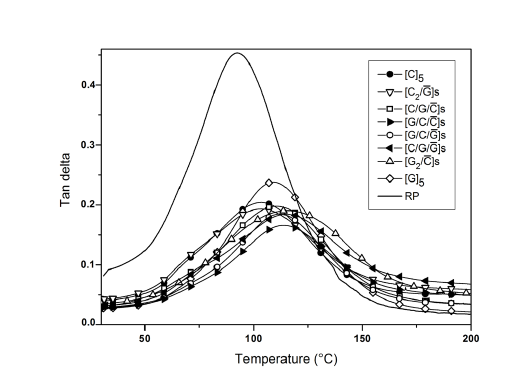
Figure 8. Tan delta curves of the resin and the